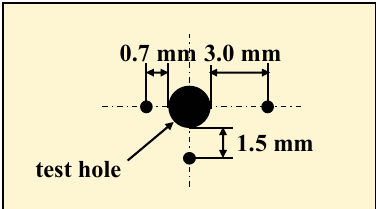
Fig. 4 Diagrams showing the predrilled thermocouple